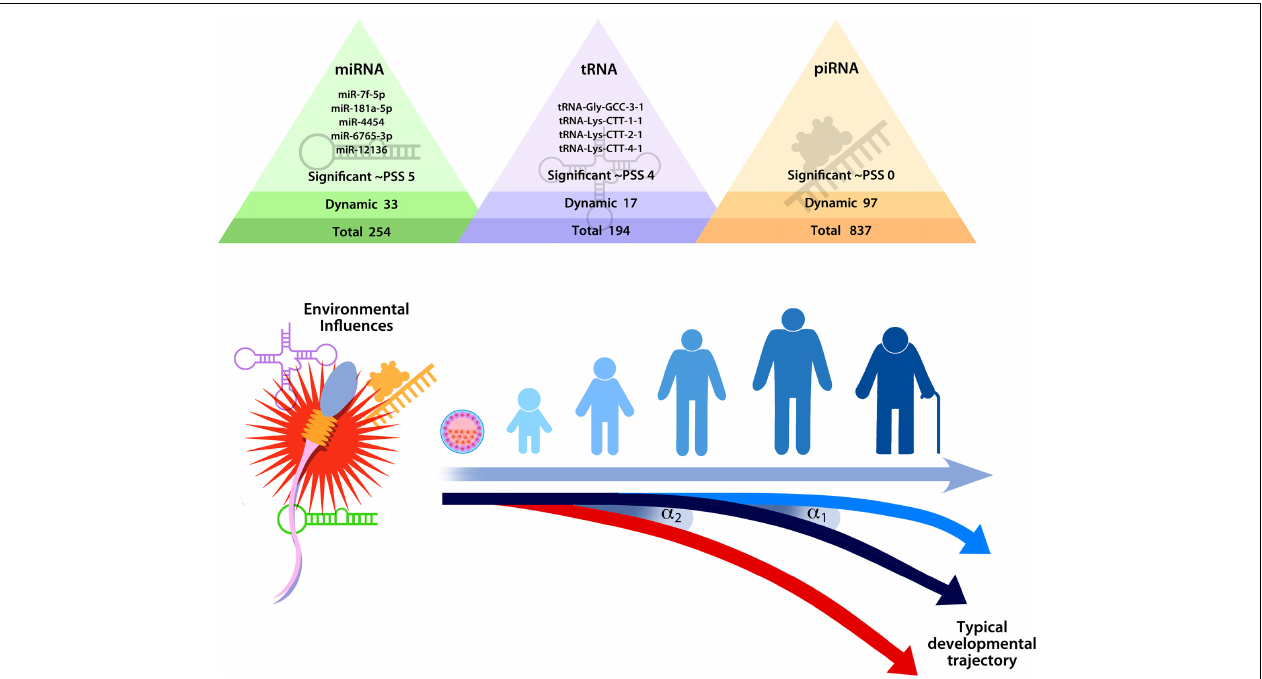
FIGURE 3 | Hypothesized model of the impact of stress on sperm small non-coding RNA content on developmental trajectories, highlighting the fact that relatively minor changes in sperm small non-coding RNA (as indicated by α 1 or α 2) could shift the timing of developmental events (e.g., embryo division and implantation) in ways that produce significant differences over time. Reprinted from Morgan et al. (2020). Repeated sampling facilitates within- and between-subject modeling of the human sperm transcriptome to identify dynamic and stress-responsive sncRNAs. Scientific Reports. 10:17498. https://creativecommons.org/licenses/by/4.0/.